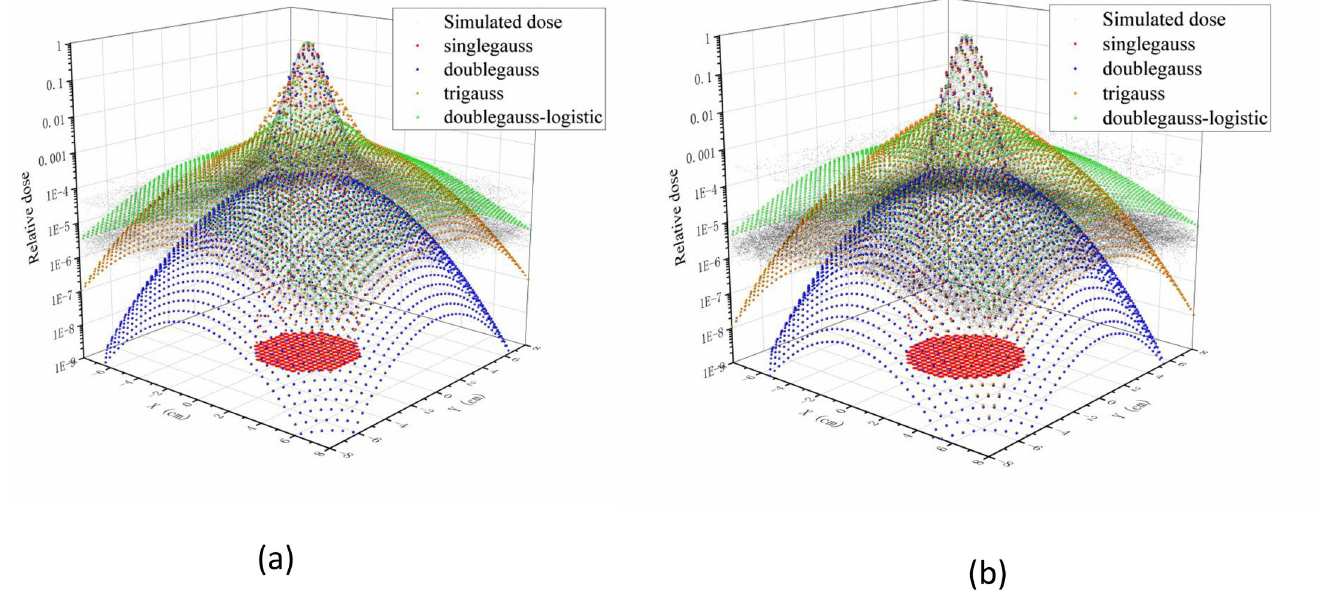
Fig 4. Carbon-ion PB distribution was modeled by Origin software. 3D dose distributions of the total dose for (a)190 MeV/u and (b) 260 MeV/u carbon-ion PB. All data were normalized with the maximum dose value.